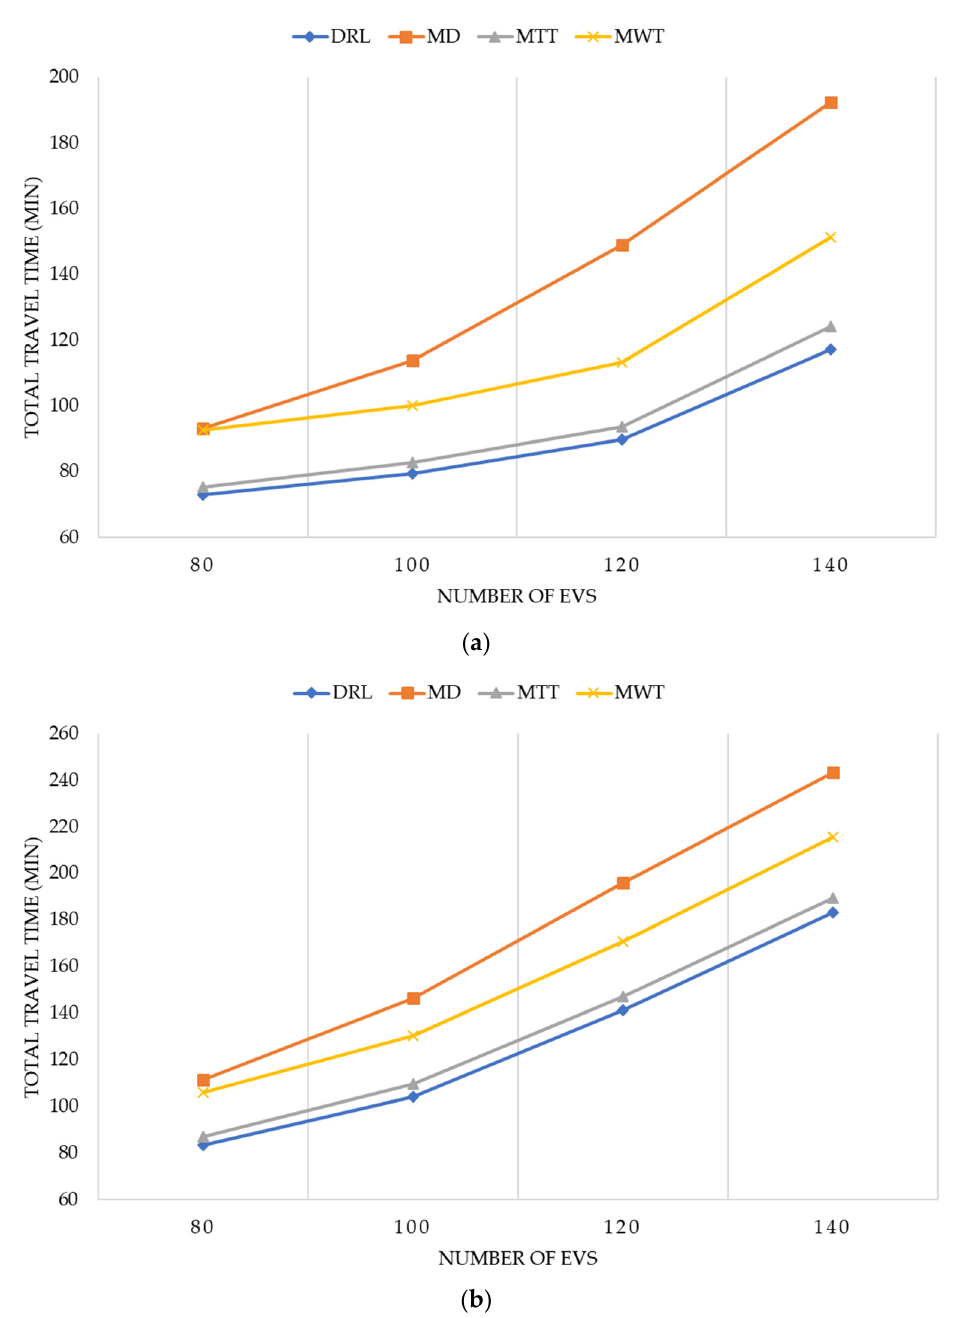
Figure 10. Average travel time of different number of EVs according to distributions: ( a ) Uniform distribution; ( b ) Normal distribution.